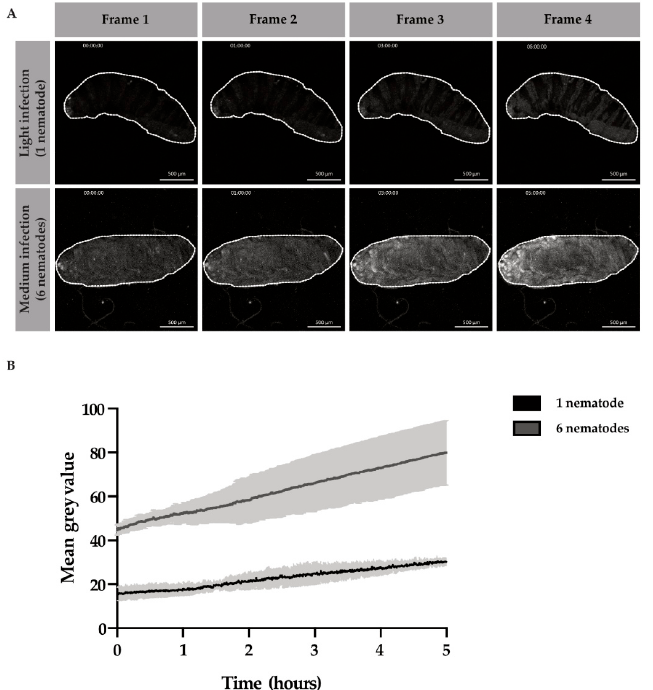
Figure 3. Light and medium infection of the EPN Heterorhabditis bacteriophora and their symbiotic bacteria, Photorhabdus luminescens -GFP, in Drosophila melanogaster . Time-lapse images acquired for light and medium infection that show stills from 0, 1, 3, and 5 h after 1 h of infection ( A ). Graphs demonstrating the mean grey value of bacterial proliferation of Photorhabdus luminescens inside the larva from 1 to 6 h after infection ( B ). Scale bar 500 μ m.